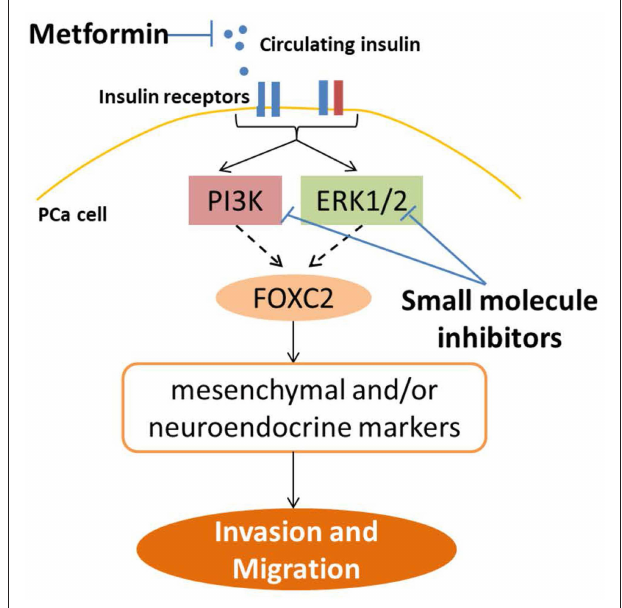
FIGURE 8 | Strategies to inhibit insulin induced PCa invasion and plasticity. This study shows insulin receptors in PCa cells can signal through a combination of PI3K/Akt and RAS/RAF/MAPK pathways, and in LNCaP cells, up-regulate FOXC2 transcription factor, which then activates transcription of a series of EMT and NE markers, to promote gain of cell invasion and migration. This pathway can be blocked top-down by reducing ADT-induced systemic hyperinsulinemia in PCa patients through use of anti-diabetic drug such as metformin, to reduce circulating insulin levels and ligand availability for insulin receptors in PCa cells. Alternatively, signaling may also be targeted downstream of the insulin receptors by targeting PI3K and MAPK pathways with small molecule inhibitors. Direct inhibition of insulin receptors, either IR or IGF1R, leads to worsening of insulin resistance and hyperinsulinemia in patients and are not viable for clinical use in PCa (